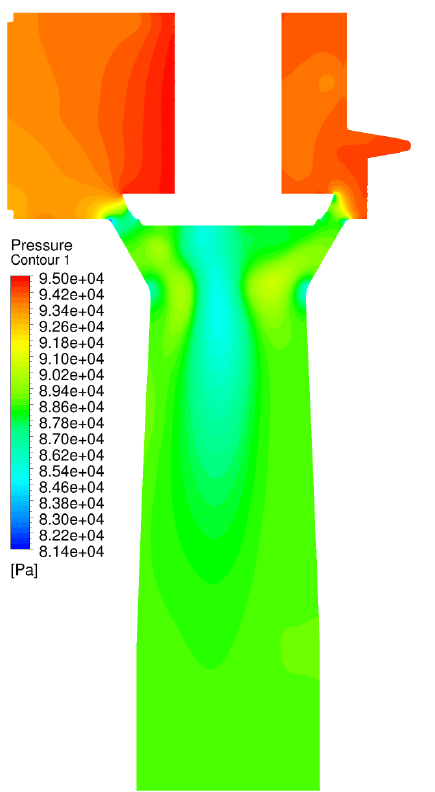
Fig. 9. Pressure flow field in the compact valve with the new chamber